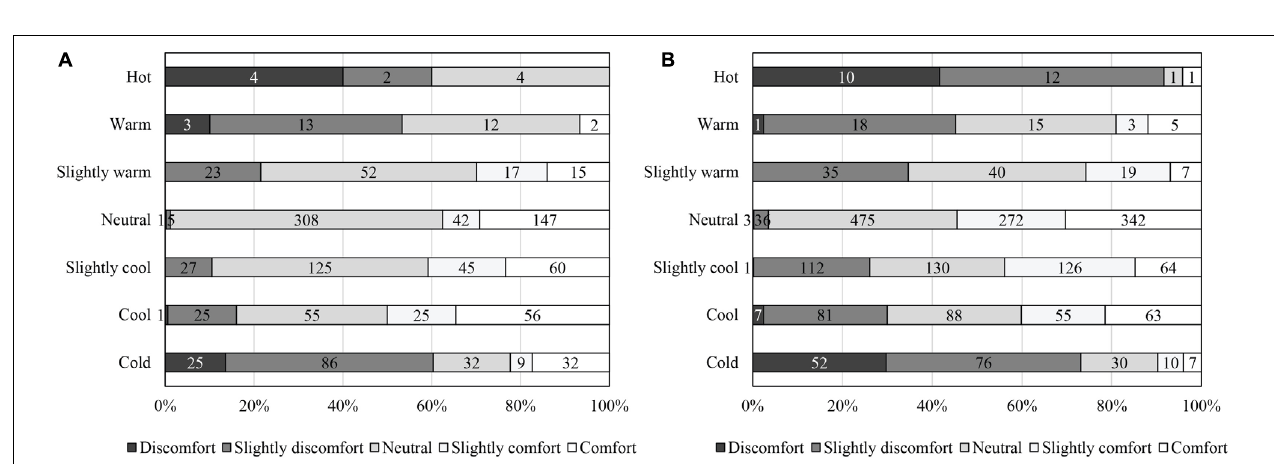
FIGURE 4 | Relation between thermal sensation votes and thermal comfort votes: (A) Singapore and (B) Thailand.